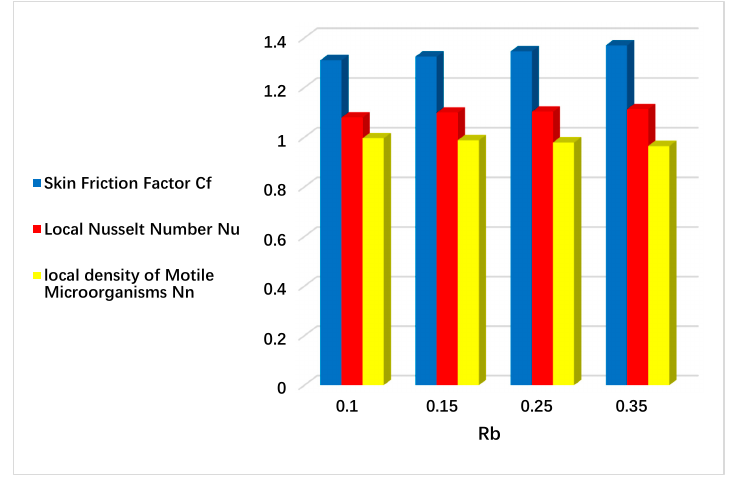
Figure 19. Influence of Rb on C f , Nu, and Nn .